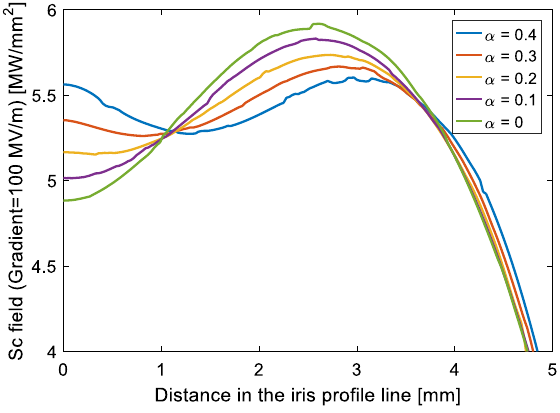
FIG. 6. Geometric parameters of the single cell: (a) Cut view of YZ plane; (b) view of the disk in the XY plane. See Fig. 4 for the orientation of each view. FIG. 7. Magnetic field distribution vs wall